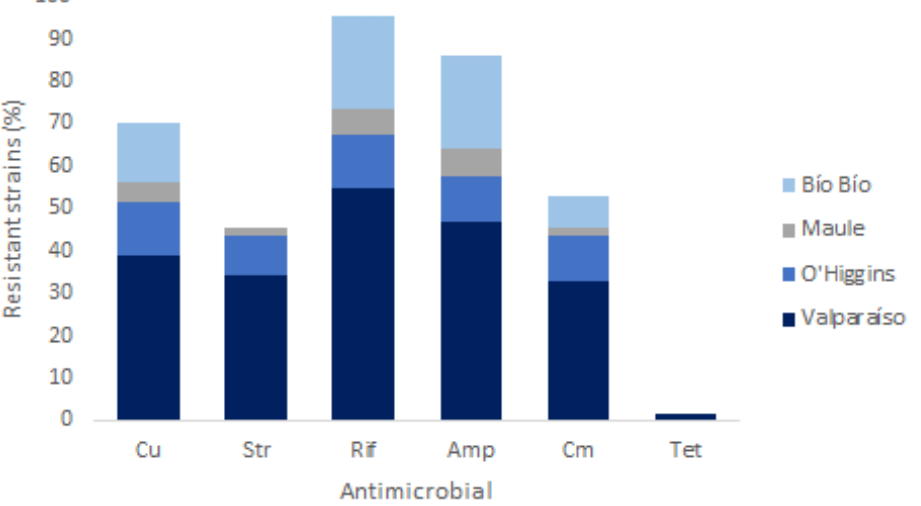
Figure 3. Presence and distribution of antimicrobial resistant Pseudomonas isolates from different Chilean regions. Data are expressed as percentage of total isolates. Antimicrobial are abbreviated as follows: Cu, copper; Str, streptomycin; Rif, rifampin; Amp, ampicillin; Cm, chloramphenicol; Tet, tetracycline. Table 5. Antimicrobial susceptibility of the Pseudomonas isolates. MIC (µg/mL)